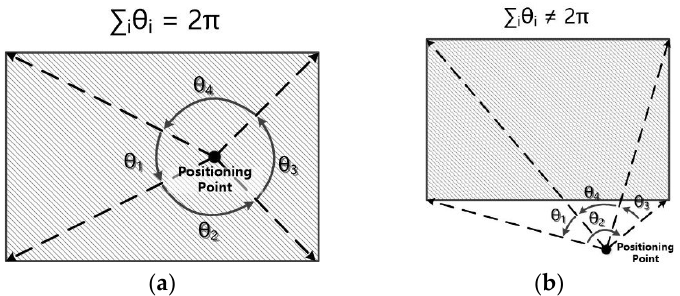
Figure 4. Positioning conditions of location point. ( a ) Inside the scene; ( b ) outside the scene. Algorithm 1 Feature vector